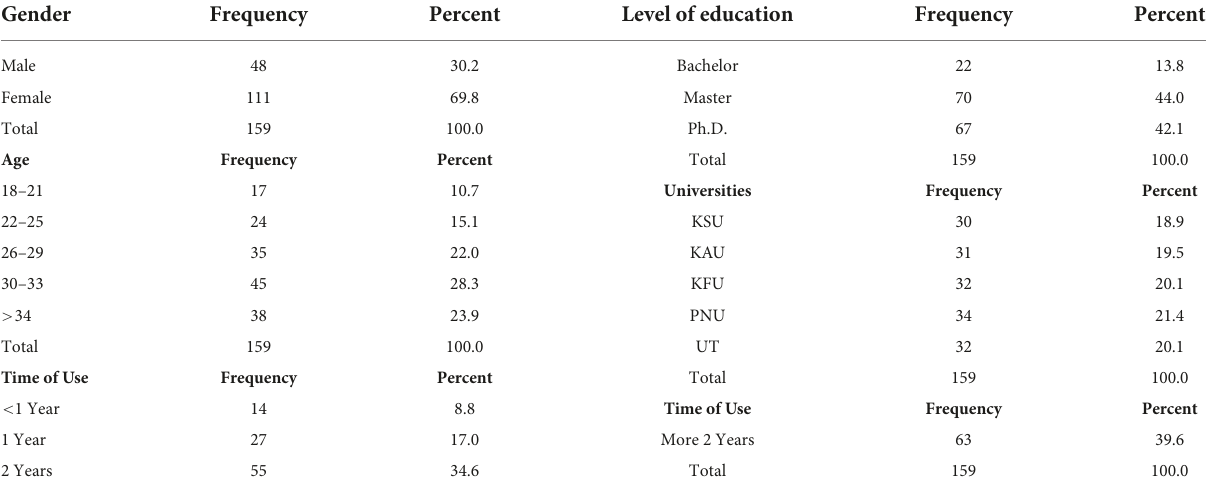
TABLE 1 Demographic